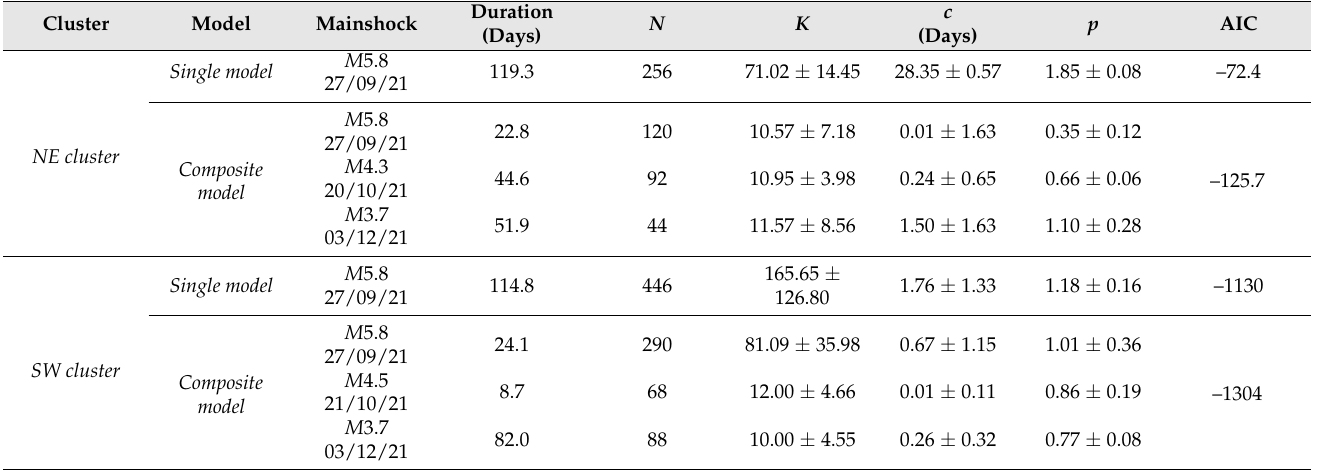
Table 7. The considered mainshock, the duration (in days), the number of events (N), and the MLE of the modified Omori formula parameters for the NE and SW aftershock clusters, along with their associated uncertainties. AIC is the estimated Akaike Information Criterion for each